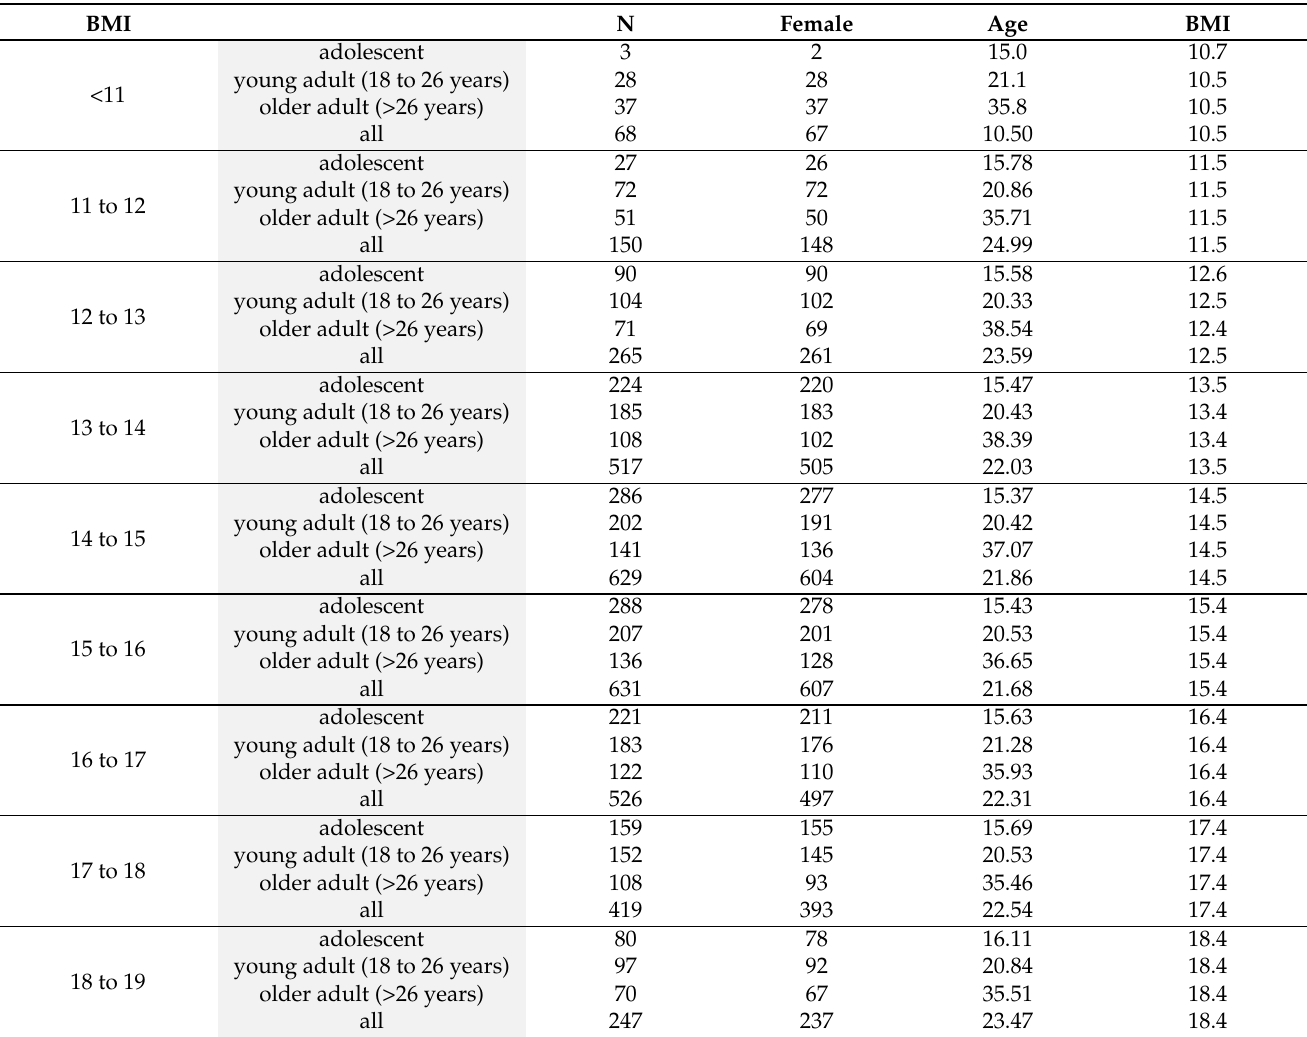
Table 2. Gender, BMI, and age (sample 1)